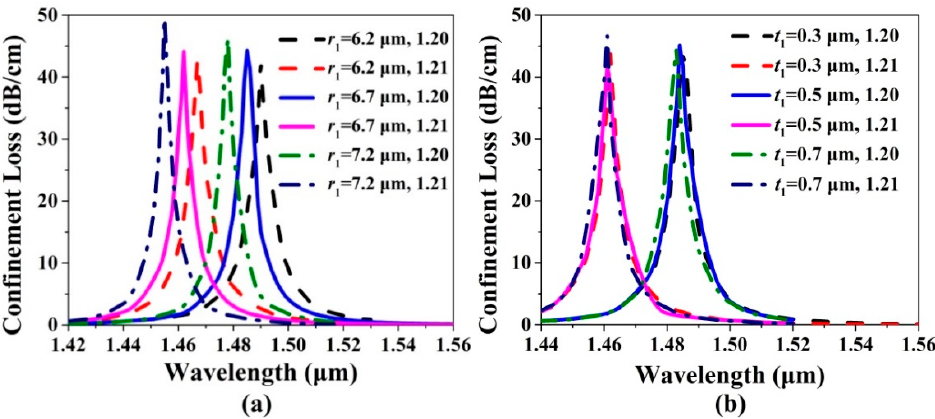
Figure 3. The confinement loss spectra of the x -pol core mode when ( a ) r 1 increases from 6.2 to 7.2 μ m and ( b ) t 1 increases from 0.3 to 0.7 μ m for the RIs of the filled analyte of 1.20 and 1.21, respectively.